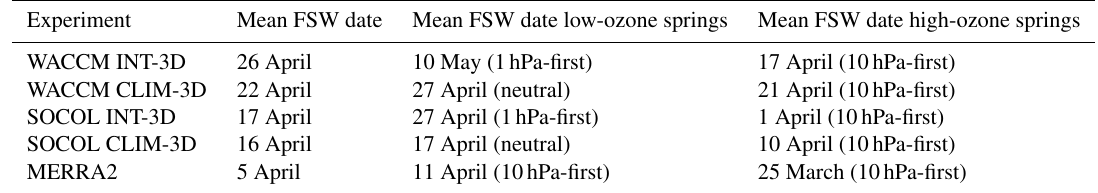
Table 1. FSW dates at 50hPa in high- and low-ozone springs. Mean FSW dates in high-ozone and low-ozone years and mean FSW date at 50hPa over all years in WACCM and SOCOL-MPIOM for both INT-3D and CLIM-3D, as well as for